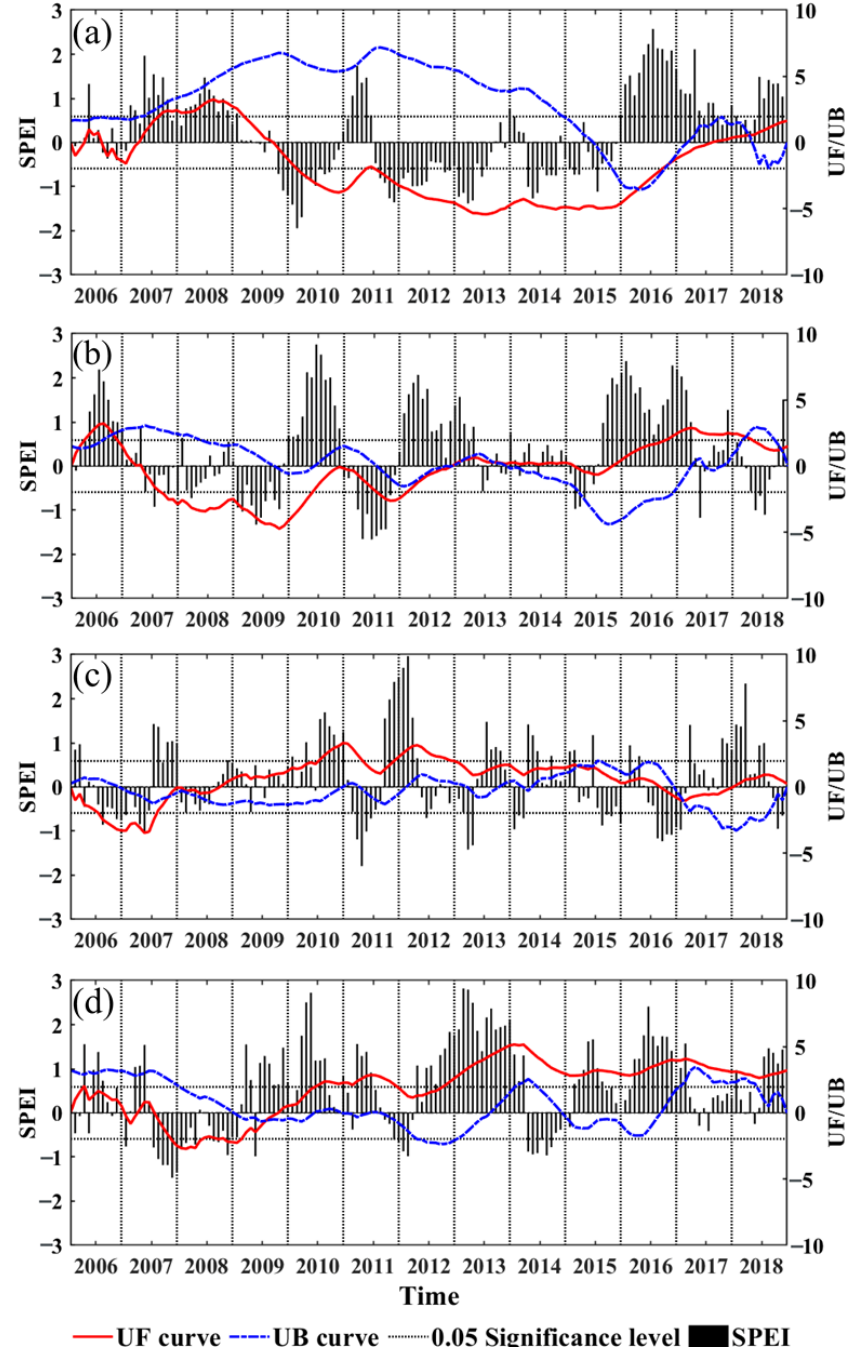
Figure 2. Inter-annual variation and Mann–Kendall test curves of SPEI in four provinces from 2006 to 2018. UF was obtained from the forward sequence data of SPEI. UB was obtained from the inverse sequence data of SPEI. ( a ) Yunnan province; ( b ) Fujian province; ( c ) Shaanxi province; and ( d ) Heilongjiang province.